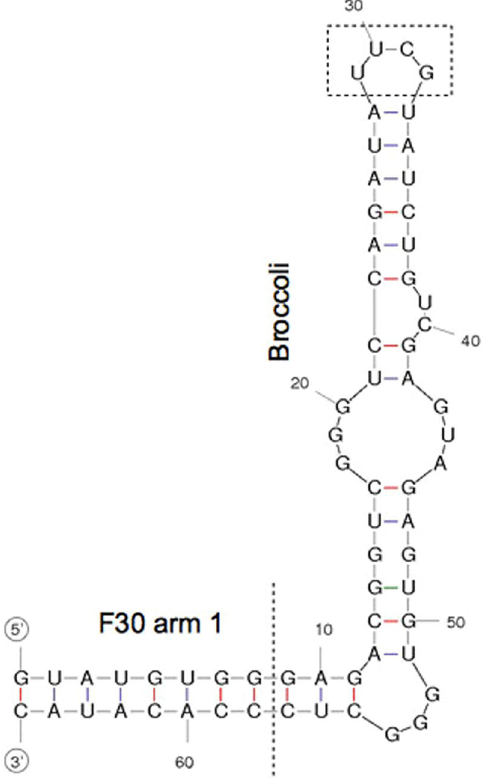
Figure 2. Sequence and mFold predicted structure of Broccoli aptamer with part of the F30 arm 1 used in this study. To obtain the split system, two sequences complementary to the DBS scaffold were added at the 5 ′ and 3 ′ ends (circles), and the 4-nt terminal stem loop (rectangle) was